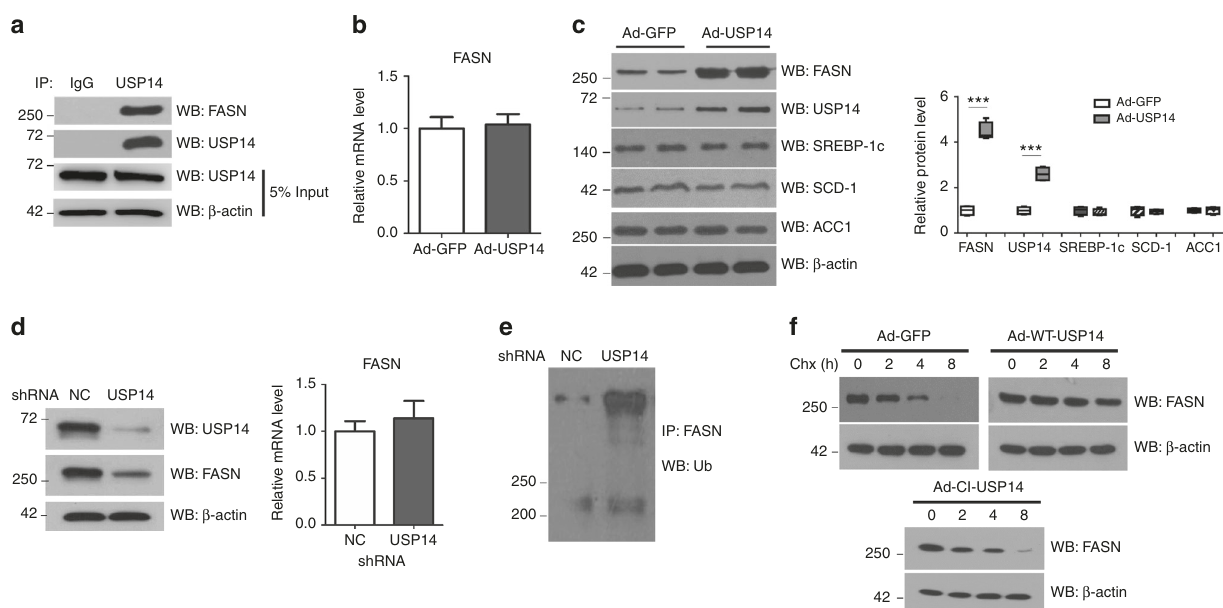
Fig. 5 Identi fi cation of FASN as a direct target of USP14. a The lysate from mouse primary hepatocytes (MPH) were incubated with either anti-USP14 antibody or normal rabbit IgG, and the immunocomplexes were probed with the indicated antibodies. b Relative mRNA levels of FASN in MPH overexpressing USP14 or GFP for 48 h. c Representative protein levels of SREBP-1c, SCD-1 and ACC1 in MPH were shown and with the quanti fi cation plot based on scanning densitometry analysis ( n = 4 for each group). The two lanes are two representative biological replicates. Each lane represents the tissue protein sample from one mouse. *** p < 0.001 versus indicated groups (Student ’ s t- test). d MPH were transfected with shRNA targeting USP14 or negative control (NC) for 48 h. The protein levels of FASN, USP14 and β -actin were detected by western blot with the indicated antibodies and relative mRNA levels of FASN were determined by quantitative PCR. e MPH with or without USP14 knockdown were treated with 25 µ g/mL cycloheximide (CHX) for the indicated time. The whole cell lysate was detected by western blot with the indicated antibodies. f MPH with or without USP14 overexpression were treated with 25 µ g/mL cycloheximide (CHX) for the indicated time. The whole cell lysate was detected by western blot. Data are presented as mean ±